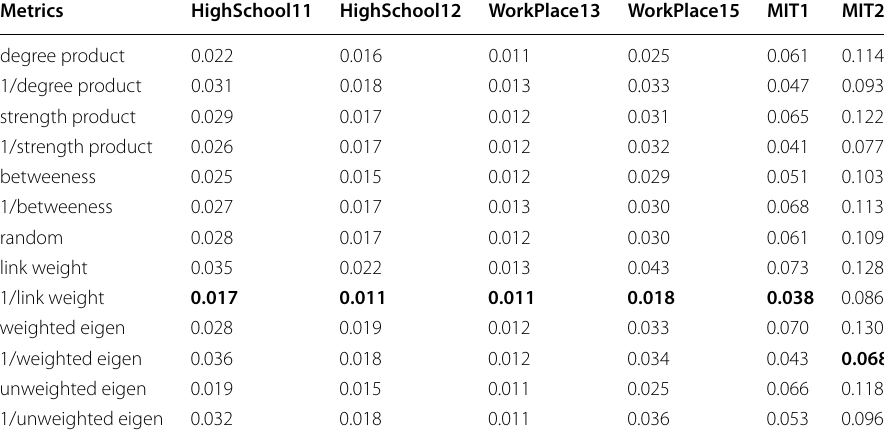
The lowest average prevalence value for each dataset is highlighted in bold